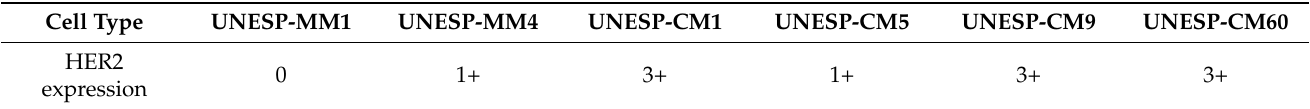
Table 1. Classification of samples used in the study according to the expression of HER2 determined by immunohistochem- istry using Herceptest TM . The samples received scores according to the recommendations of the kit used. Cell